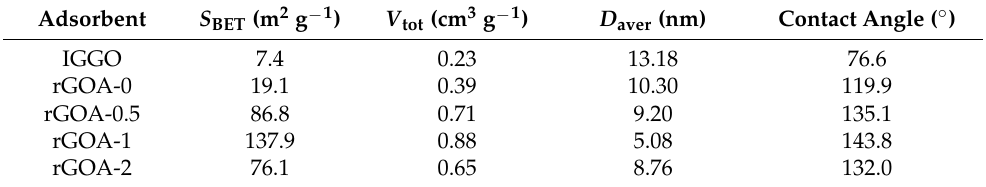
Table 1. Properties of industrial-grade multilayer graphene oxide (IGGO) and reduced graphene-oxide aerogels (rGOAs). Adsorbent